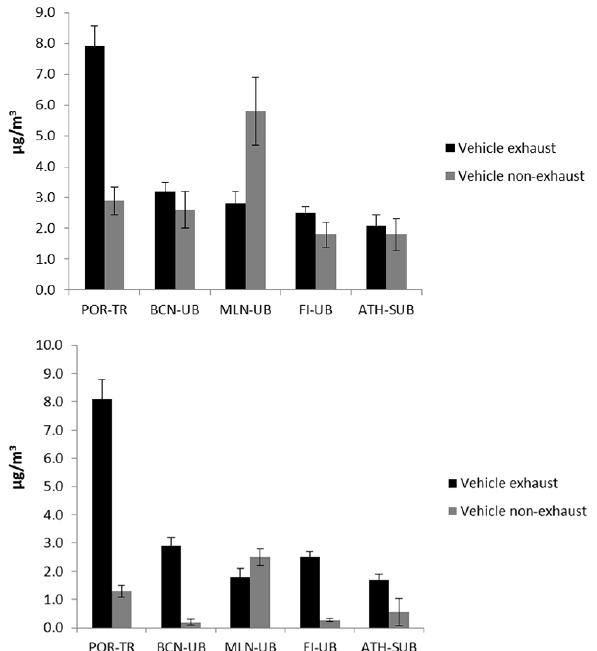
Figure 6. Mean contributions for traffic-related sources at the five AIRUSE cities for PM 10 (top panel) and PM 2 . 5 (bottom panel). Er- ror bars are calculated based on the standard error of the coefficients of a multiple regression between the daily PM concentration and the source contributions, and do not include modelling